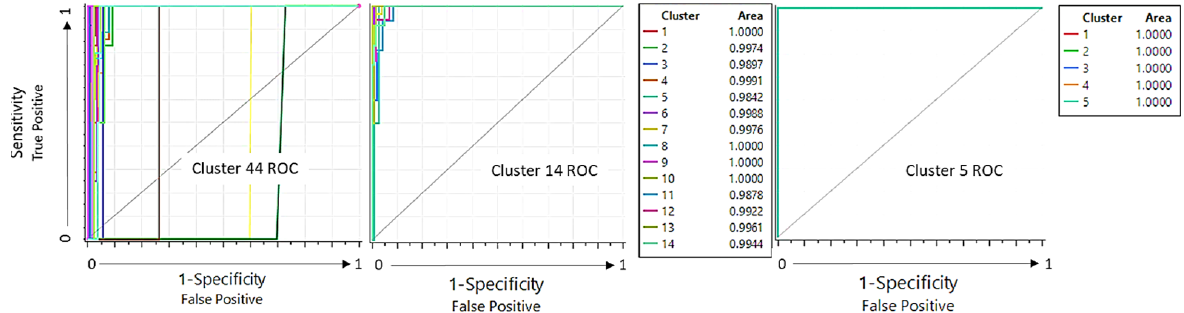
Figure 10. Classification ROC curves are shown for each cluster set. The five-cluster set achieves 100% classification accuracy while the 44-cluster set shows poor performance. The 14-cluster set shows good classification accuracy, with Clusters 5 and 11 being the least